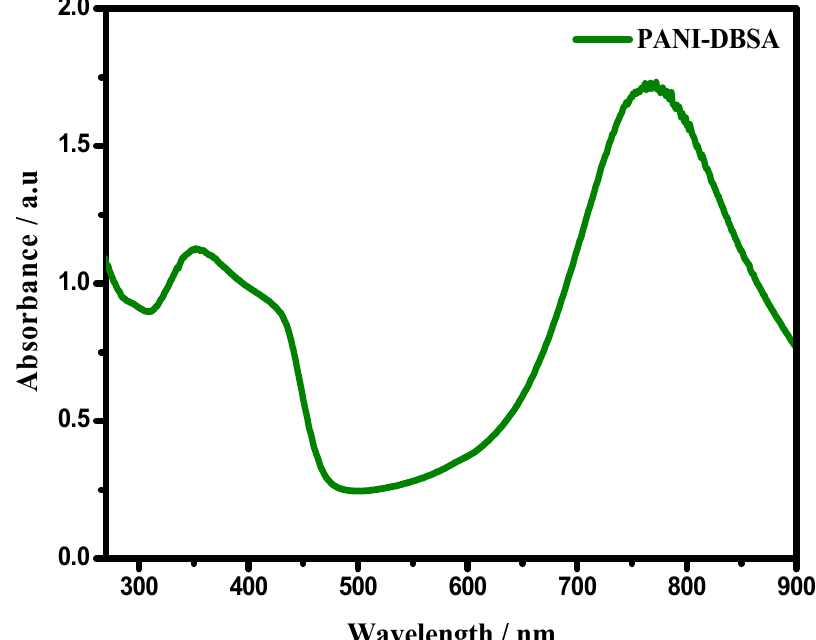
Figure 2. UV / Vis spectrum of PANI–dodecylbenzene sulfonic acid Figure 2. UV/Vis spectrum of PANI–dodecylbenzene sulfonic acid (DBSA).